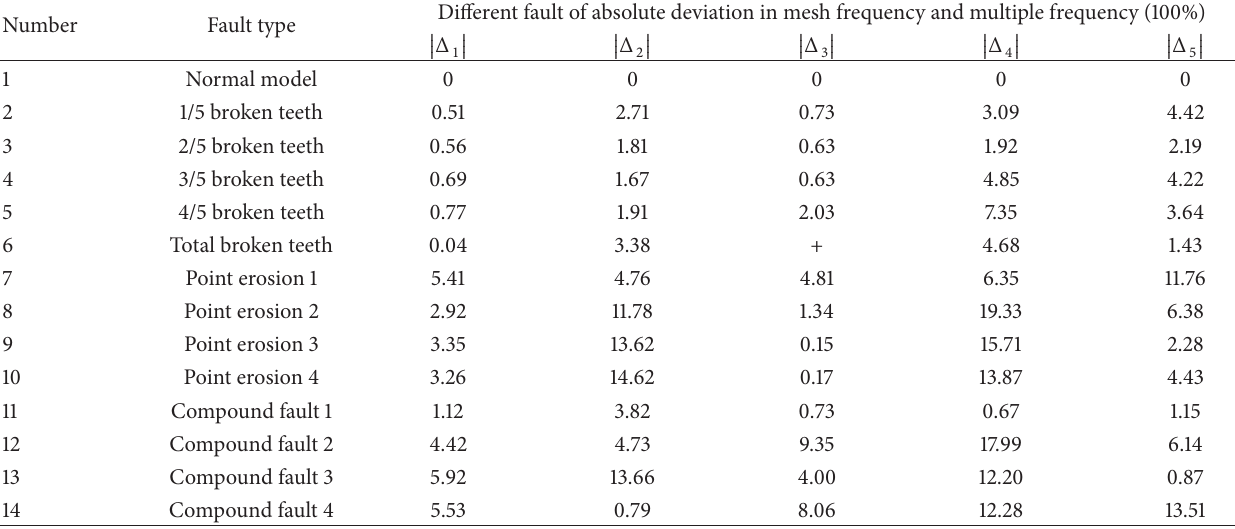
Table 3: The absolute deviation of different fault types vibration frequency